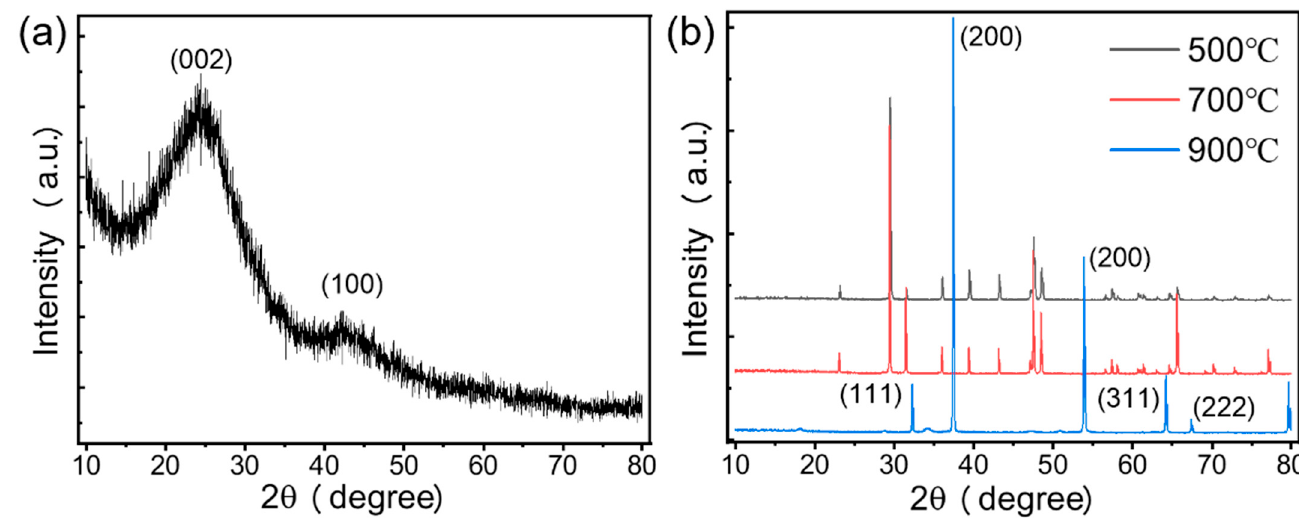
Figure 2. XRD analysis of ( a ) CN and ( b ) SS at 500, 700, and 900 ° C.